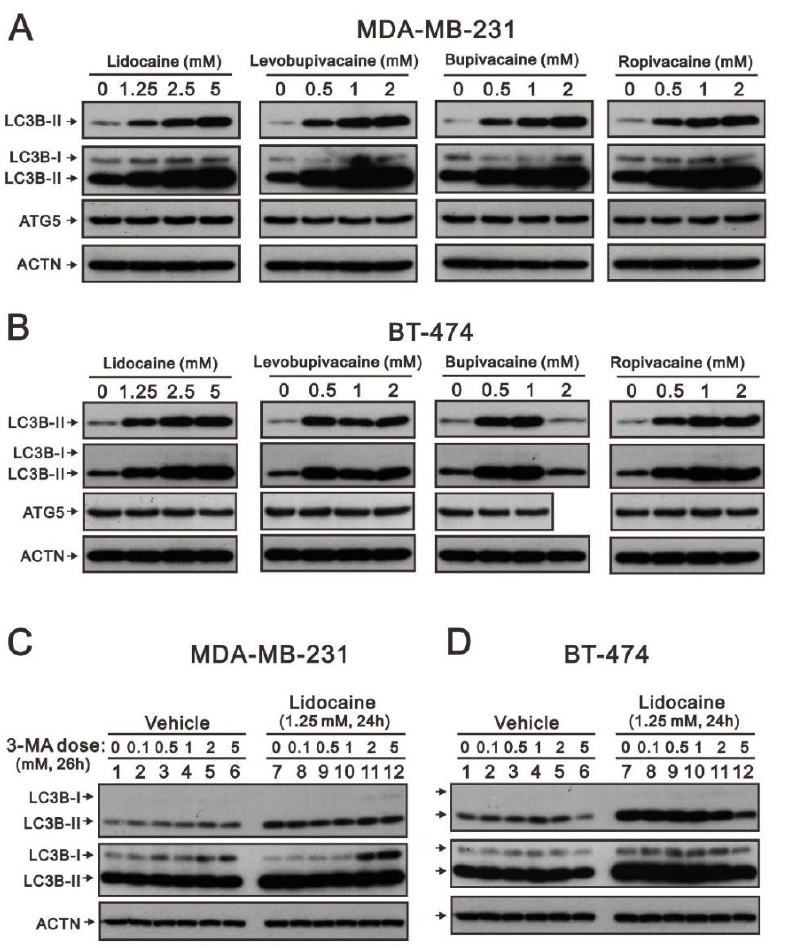
Figure 6. The effects of the local anesthetics on autophagosome-related protein expression in MDA-MB-231 and BT-474 cells. ( A ) MDA-MB-231 and ( B ) BT-474 (3 × 10 5 ) cells were treated with the indicated concentrations of lidocaine (1.25, 2.5, and 5 mM), levobupivacaine (0.5, 1, and 2 mM), bupivacaine (0.5, 1, and 2 mM), and ropivacaine (0.5, 1, and 2 mM) for 24 h; ( C ) MDA-MB-231 and ( D ) BT-474 cells were pre-treated for 2 h with 0, 0.1, 0.5, 1, 2, and 5 mM of 3-MA and then combined with 1.25 mM of lidocaine for 24 h. The cell lysates were subjected to Western blotting analysis using antibodies against the indicated proteins. ACTN was used as the protein loading control.